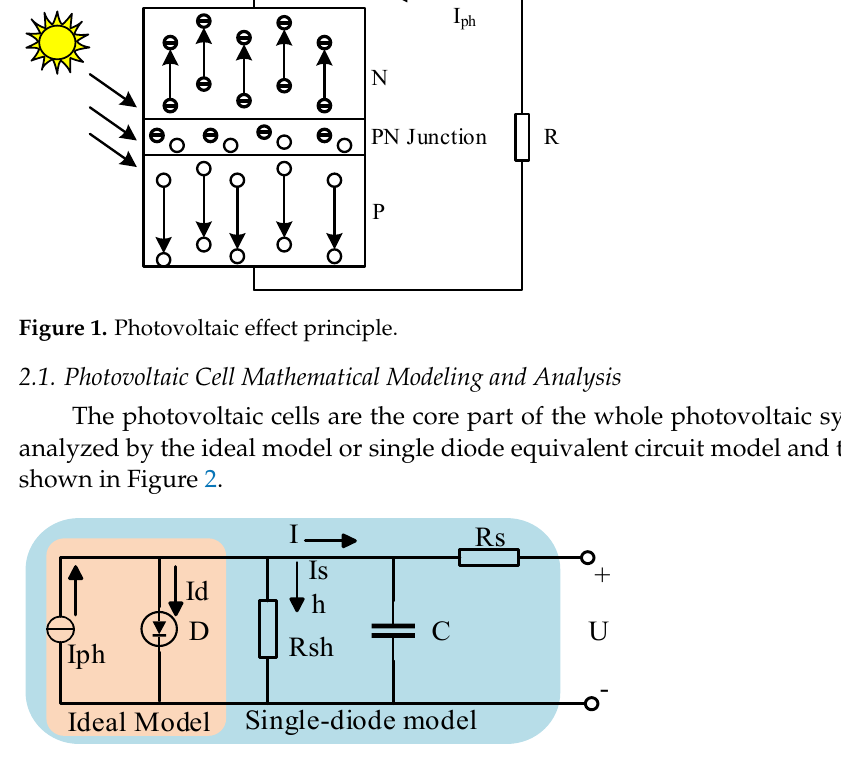
Figure 2. Photovoltaic cell equivalent circuit diagram.